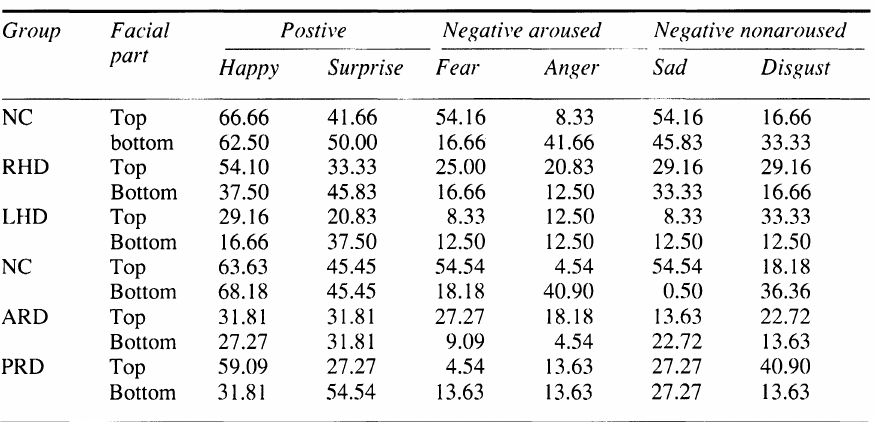
TABLE 2. Percent of correct matching for componental parts of facial emotions